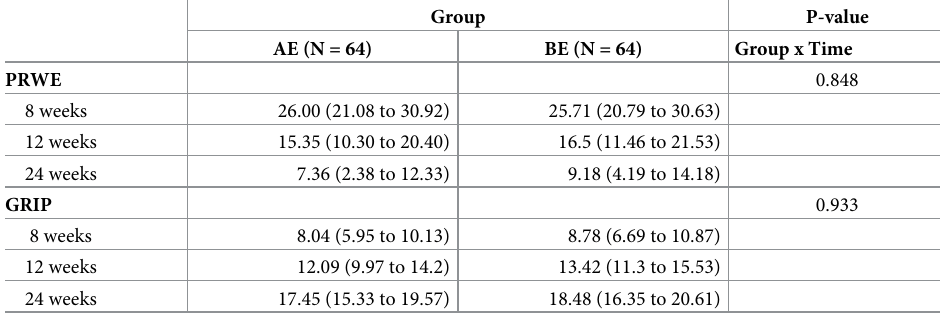
Table 3. Results of PRWE and GRIP strength, show as mean (95%CI). Group